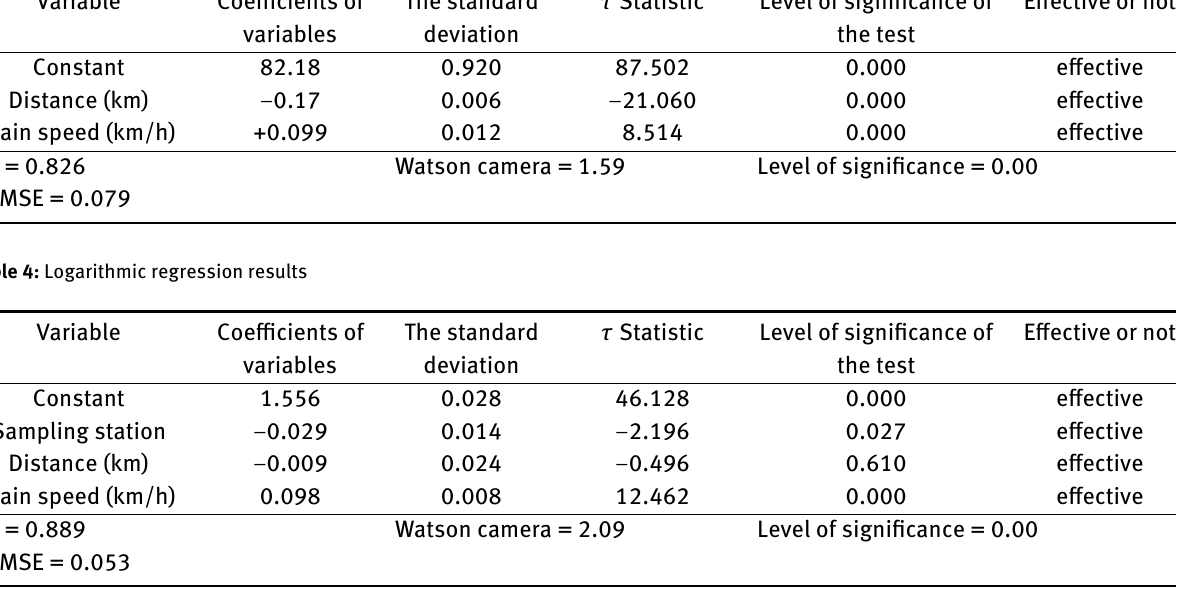
Table 3: Linear regression results Variable